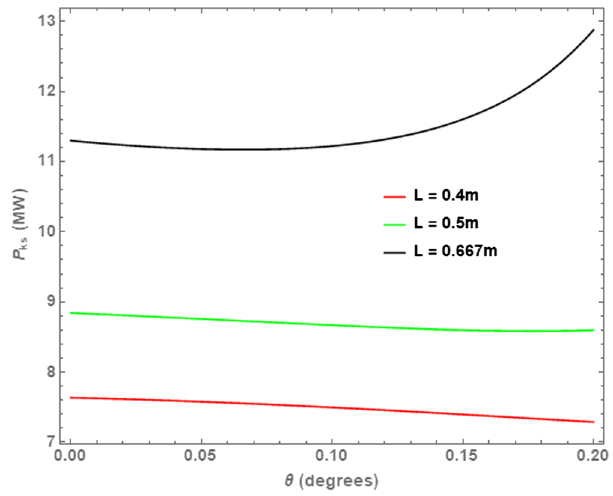
FIG. 14. The peak value of the modified Poynting vector as a function of the tapering angle θ for varying structure lengths.